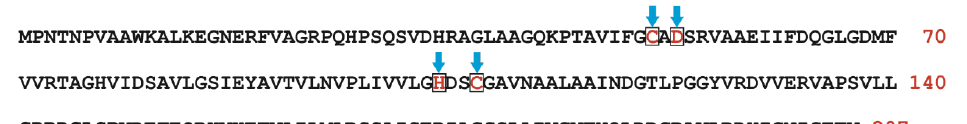
Figure 2. The β -CA2 sequence of Mtb. The β -CA (Rv3588c) protein sequence shows the amino acid residues (boxed and with blue arrows) that are involved in the coordination of the Zn(II) ion at the active site of the enzyme.